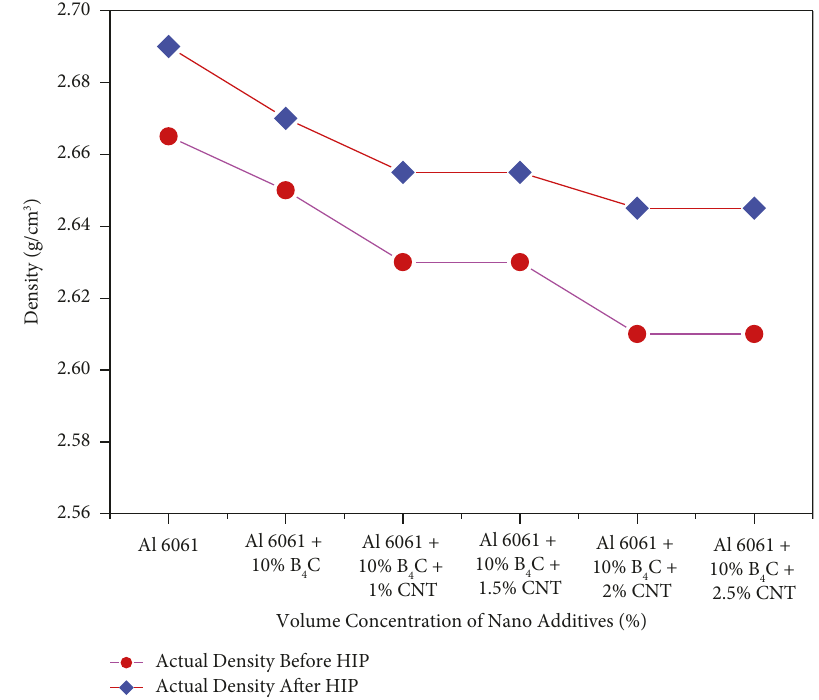
Figure 4: Before and after measurements of actual densities